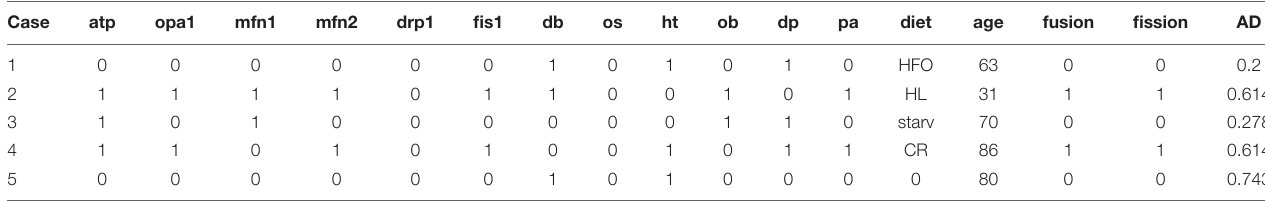
FIGURE 1 | The proposed model identifies the markers that affect Prodromal or Mixed Alzheimer’s disease development or progression (DA, Don’t Affect; HFO diet, a high-fat diet rich in fish oil; HL diet, a high-fat diet rich in saturated fatty acids). The symbol (-) shows that the parent node increases the possibility of the child node occurring. The symbol (+) shows that the current node is a deterrent factor for activating the next node. TABLE 2 | Randomly selected results from the simulation of the 1,000 patients, in accordance with the five cases